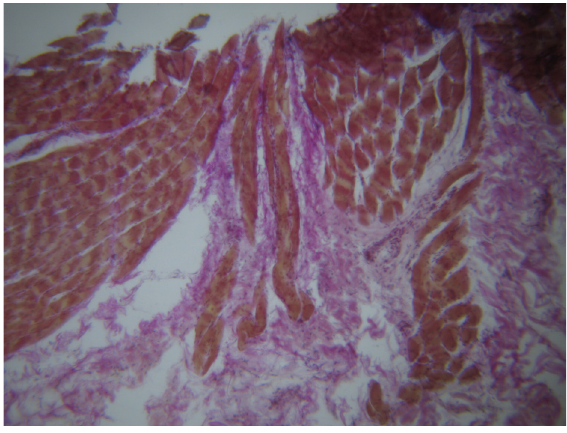
Figure 4. Microstructure of an ear tissue sample after processing with the ferment preparation Protepsin, magn. 400. (after 1 hour).